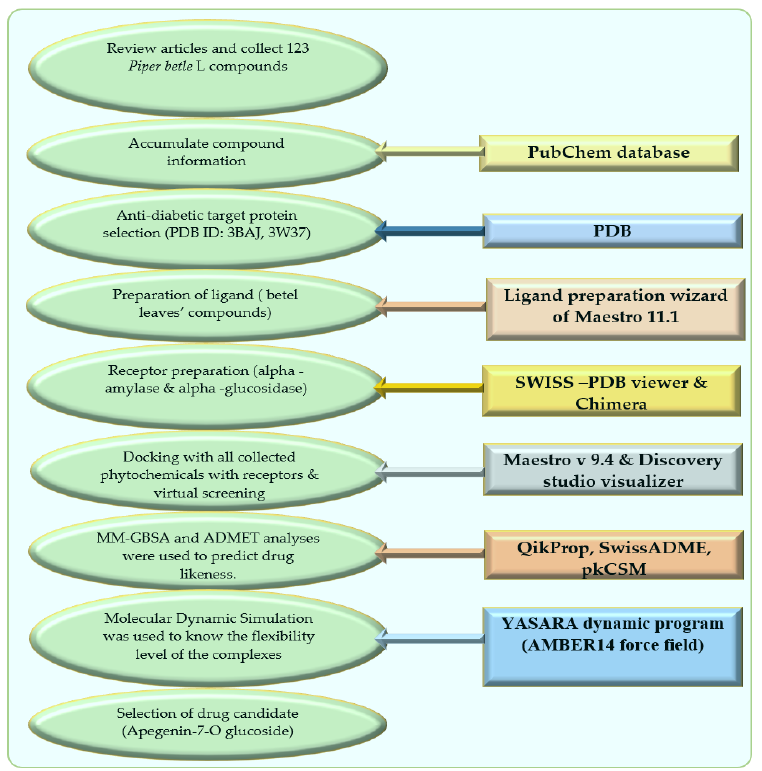
Figure 6. Schematic diagram of this study with molecular docking and dynamics simulation of natural compounds from Piper betle L.